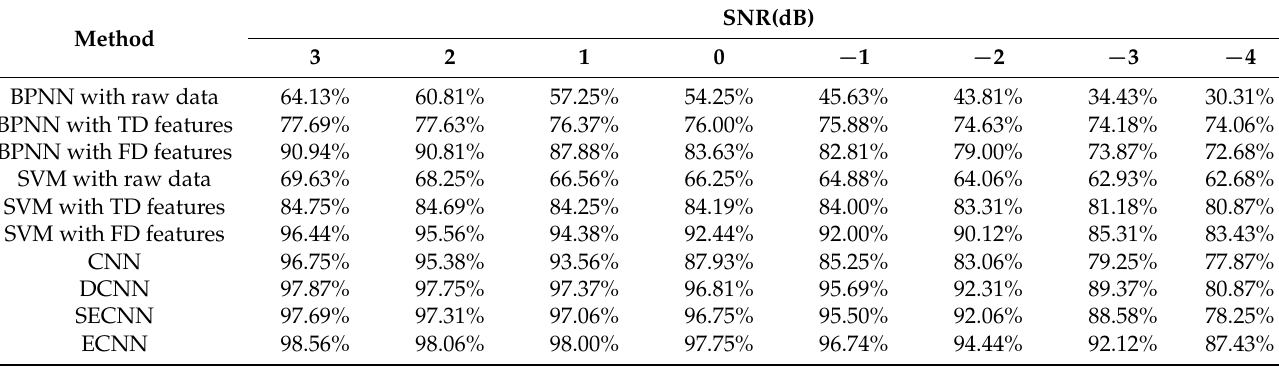
Table 5. The accuracy of each method under different